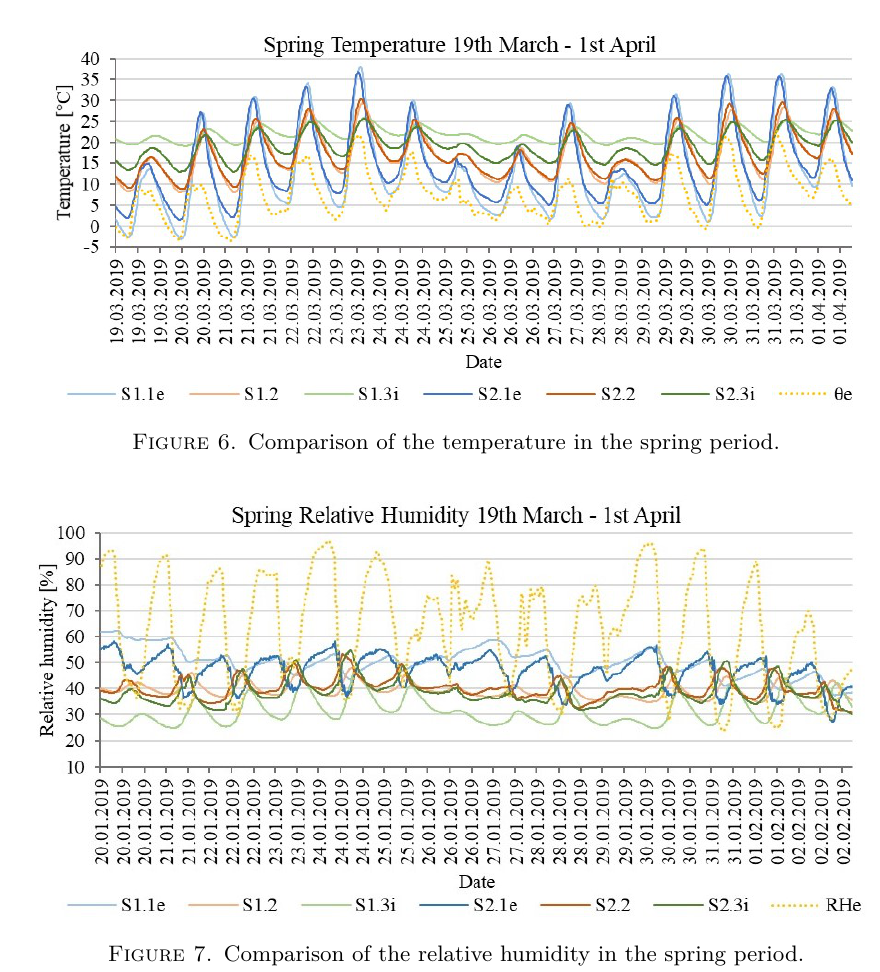
Figure 7. Comparison of the relative humidity in the spring